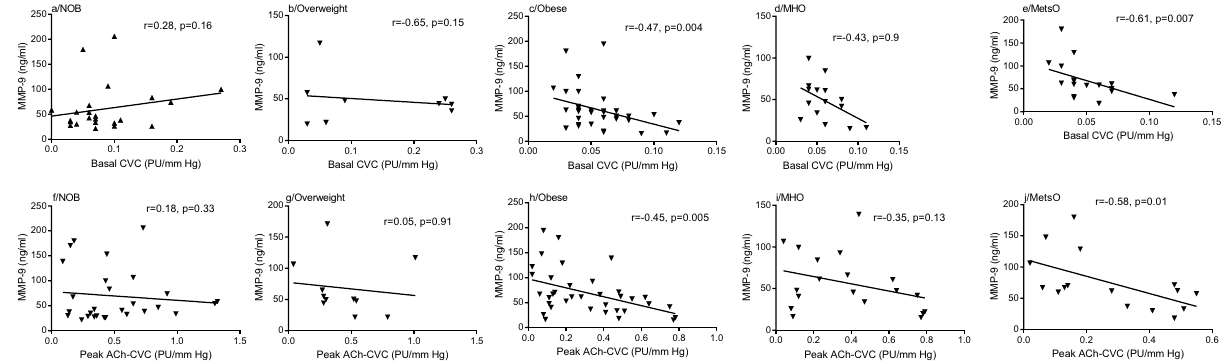
Figure 4. Spearman Rank correlation between MMP-9 plasma levels and microvascular parameters according to obesity status. Regression coefficient (r) and statistical significance (p) are reported for each test. p-value < 0.05 is significant. Ach acetylcholine, CVC cutaneous vascular conductance, NOB non-obese, MHO metabolic healthy obese, MetsO metabolic syndrome